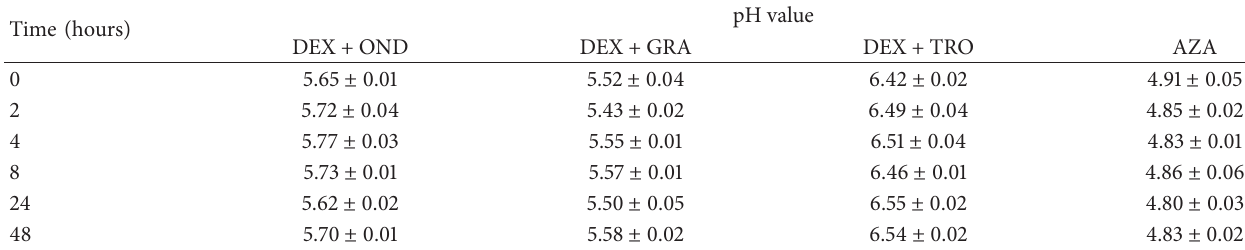
Table 4: pH values (mean ± SD; 𝑛 = 3) of the infusion samples over 48